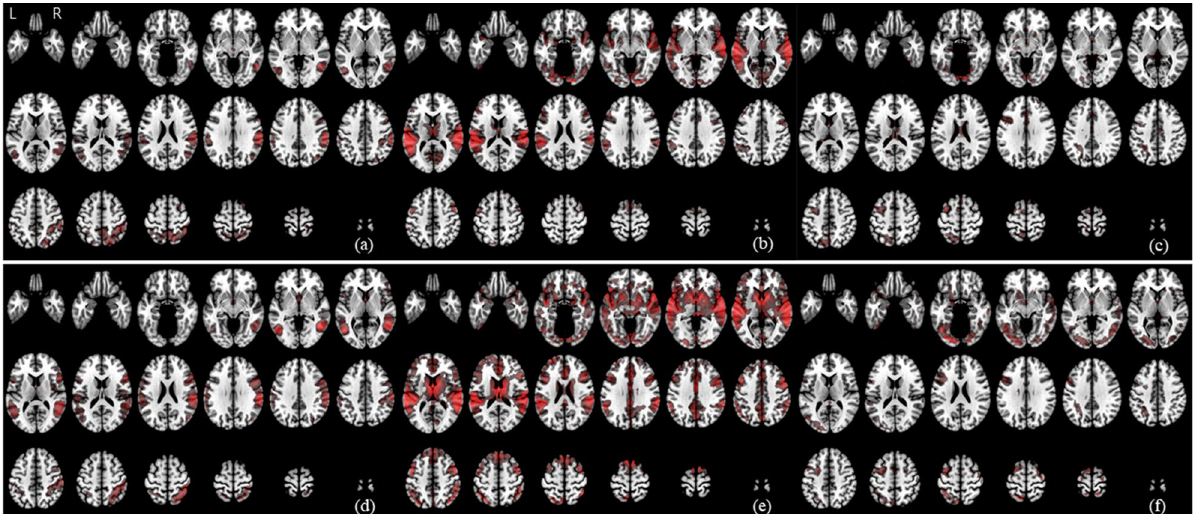
Figure 2. Representative mean cortical BOLD signal amplitudes for picture, sound, and Stroop stimuli. The mean beta values for picture ( a ), sound ( b ), and Stroop ( c ) stimuli in the PI group and for picture ( d ), sound ( e ), and Stroop ( f ) stimuli in the HC group (color scale = 0.1–0.5) are shown. The color scale represents the height of the BOLD signal (beta value) in the task (picture = sleep-related—neutral, sound = sleep-related—white noise, and Stroop =